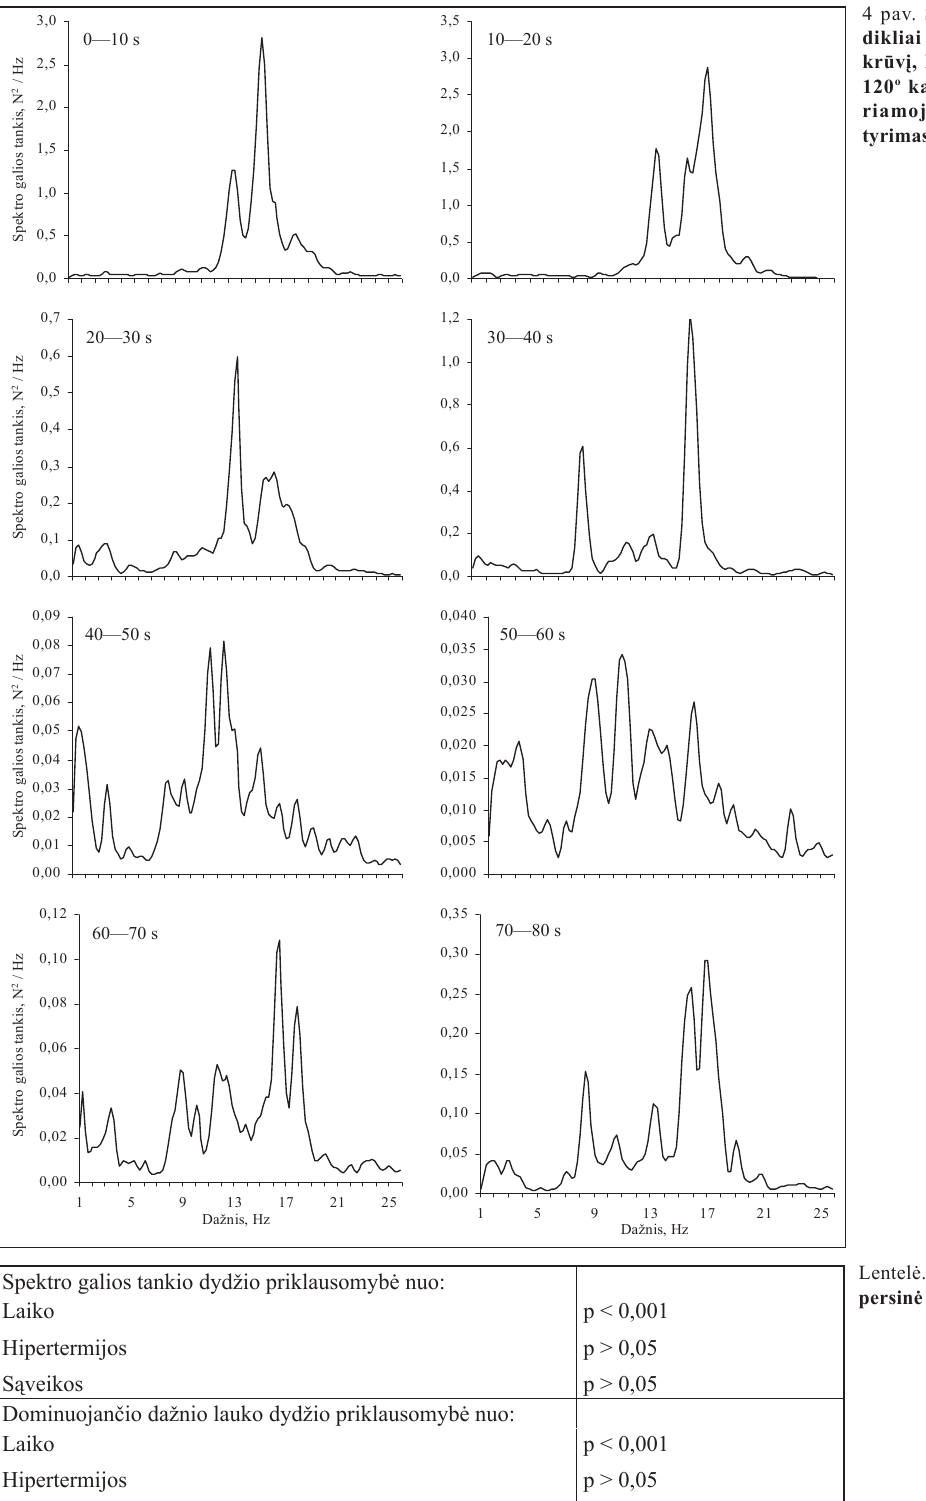
Šiuo tyrimu nustatyta: koj ų pasyvaus šildymo metu padid ė jusi rektalin ė temperat ū ra rodo tiria- m ų j ų hipertermij ą .